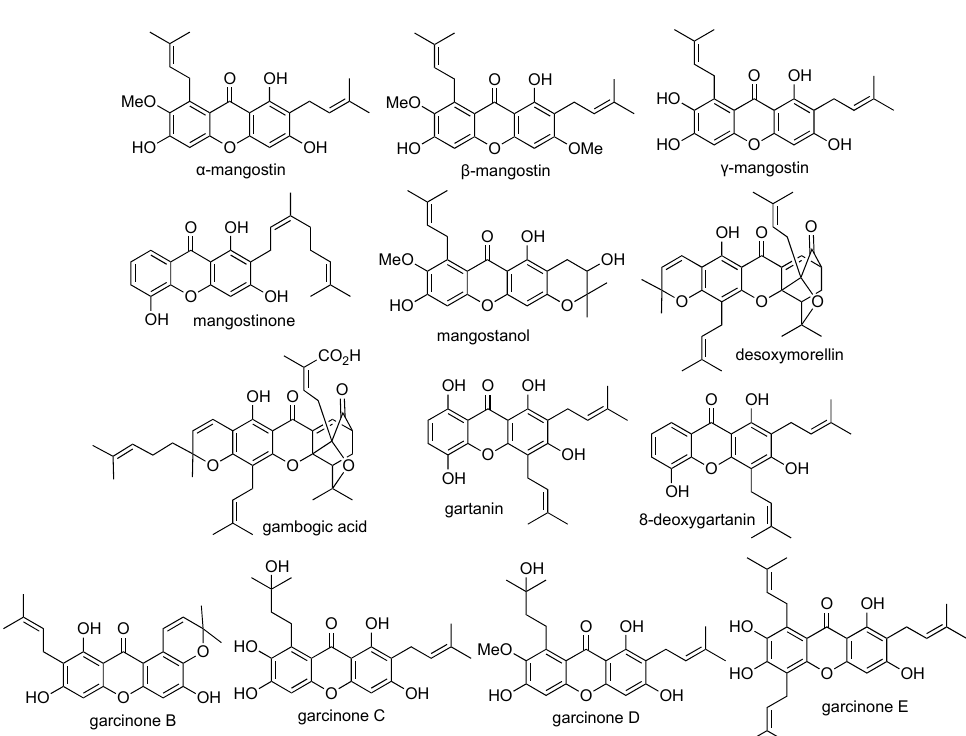
Figure 3. The chemical structure of major xanthones isolated from the pericarp of mangosteen fruit. The natural xanthone derivatives are mainly generated from acetate polymalonic and mixed shikimic acetate pathways. Birch et al. studied the acetate polymalonic pathway in the biosynthesis of ravelenin from Helminthosporium ravenelii using carbon-isotopes labeling [54] (Figure 4a). Eight acyl groups were connected with each other to form 1,3,5,7,9,11,13,15-octaketonic intermediate. Then, the octaketonic intermediate was cyclized to form benzoquinone and benzophenone intermediates. The benzophenone intermediate was further transformed to produce ravenelin. The second pathway (mixed shikimic acetate pathway) was reported by Fujita and Inoue in 1980 for mangiferin biosynthesis in Anemarrhena asphodeloides (Figure 4b) [55]. In general, one aromatic ring of xanthone was generated from the shikimic acid pathway, with another aromatic ring coming from the acetate-malonate polyketide pathway. This mixed pathway is responsible for the existence of almost all simple oxygenated and prenylated xanthone derivatives in nature. It was reported that mangiferin was produced from caffeic acid and two acetate units. Glycosidation reaction of mangiferin was found to occur on the benzophenone intermediate. Similarly, the prenylation reaction also happened on the benzophenone intermediate, and not directly on the caffeic acid one. Then, the benzophenone intermediate underwent the ring-closing reaction to form the xanthone as the final product [56].